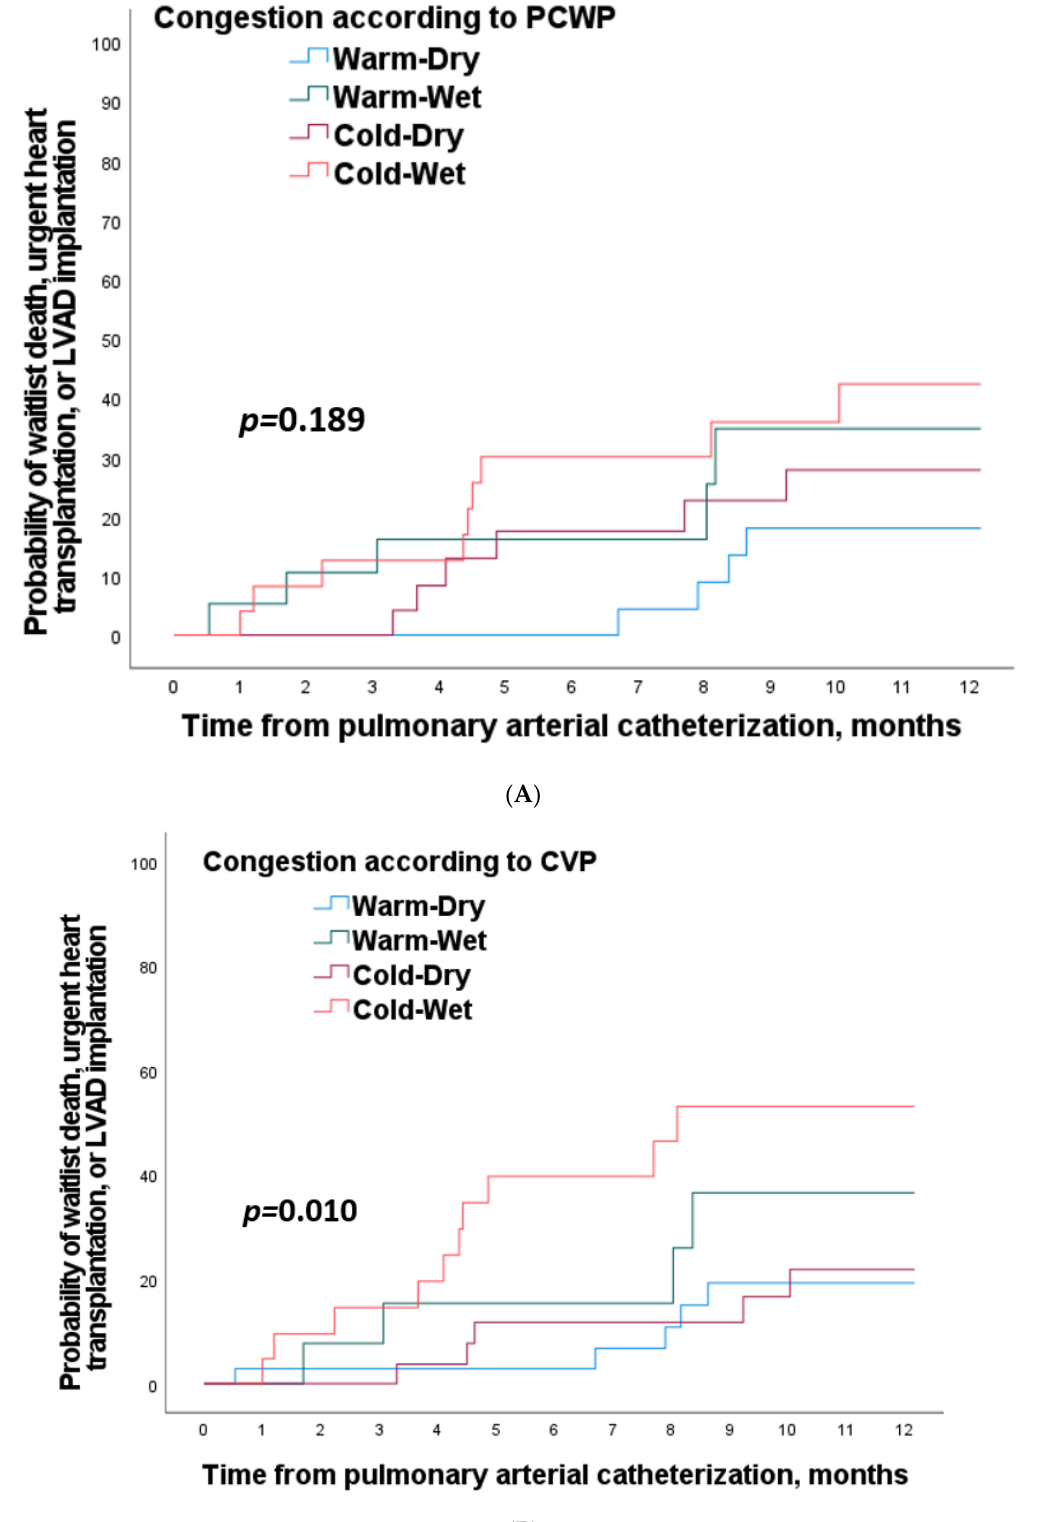
Figure 2. Kaplan – Meier curves for probability of waitlist death, urgent heart transplantation, or LVAD implantation by congestion according to PCWP ( A ) and CVP ( B ) at 12 months. CVP, central veinous pressure; LVAD, left ventricular assist device; PCWP, pulmonary capillary wedge pressure.